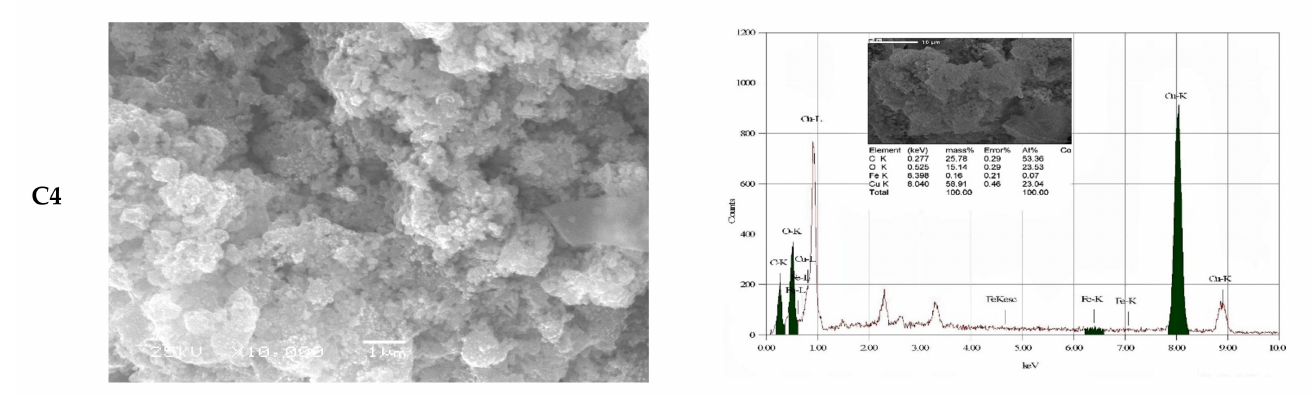
Figure 4. Scanning electron microscopy (SEM) images and energy dispersive spectrometry (EDS) patterns of the C1 , C2 , C3 , and C4